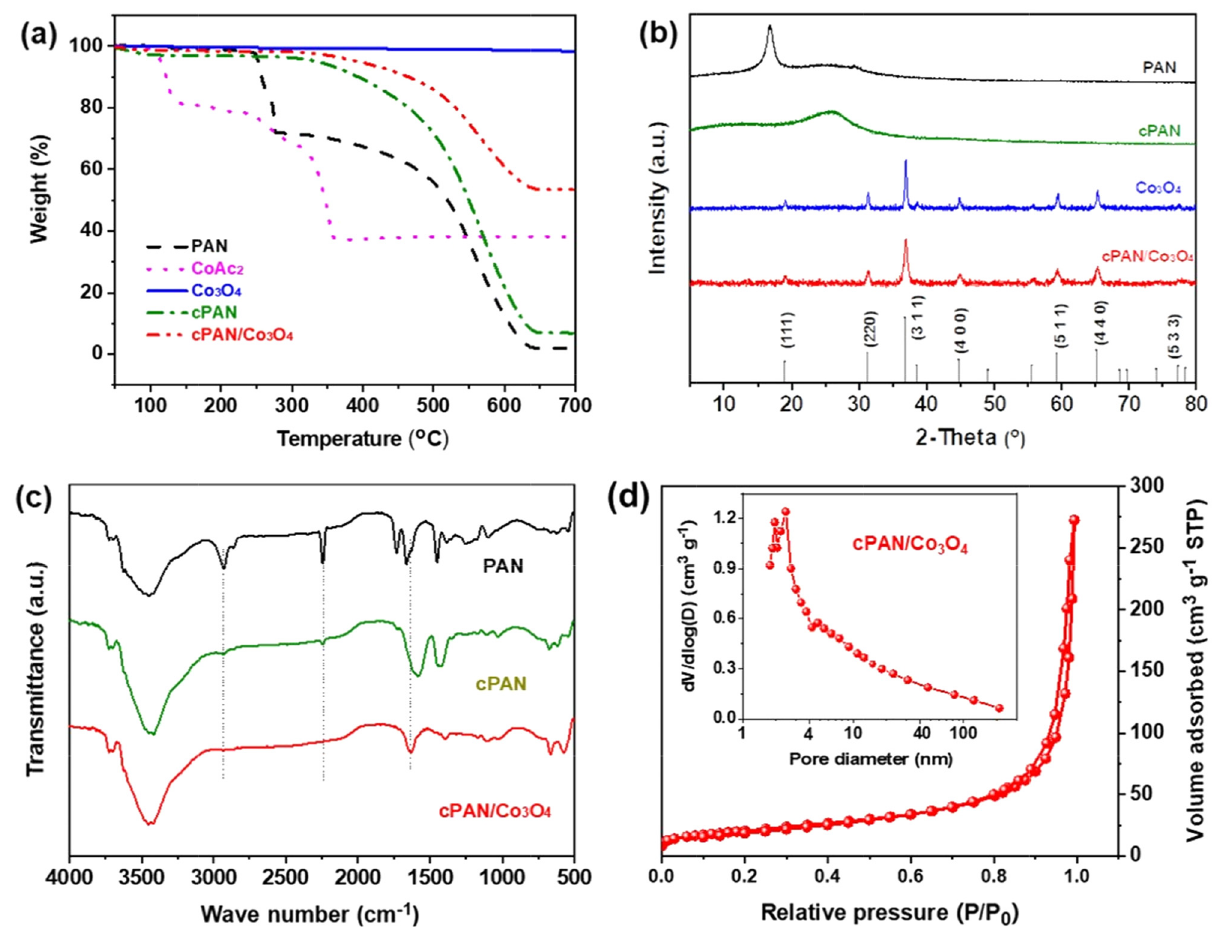
Figure 2: ( a ) TGA curves, ( b ) XRD patterns, and ( c ) FT - IR spectra of PAN, Co ( OAc ) 2 , Co 3 O 4 , cPAN, and cPAN/Co 3 O 4 . ( d ) N 2 adsorption – desorption isotherm and pore size distribution curve of cPAN/Co 3 O 4